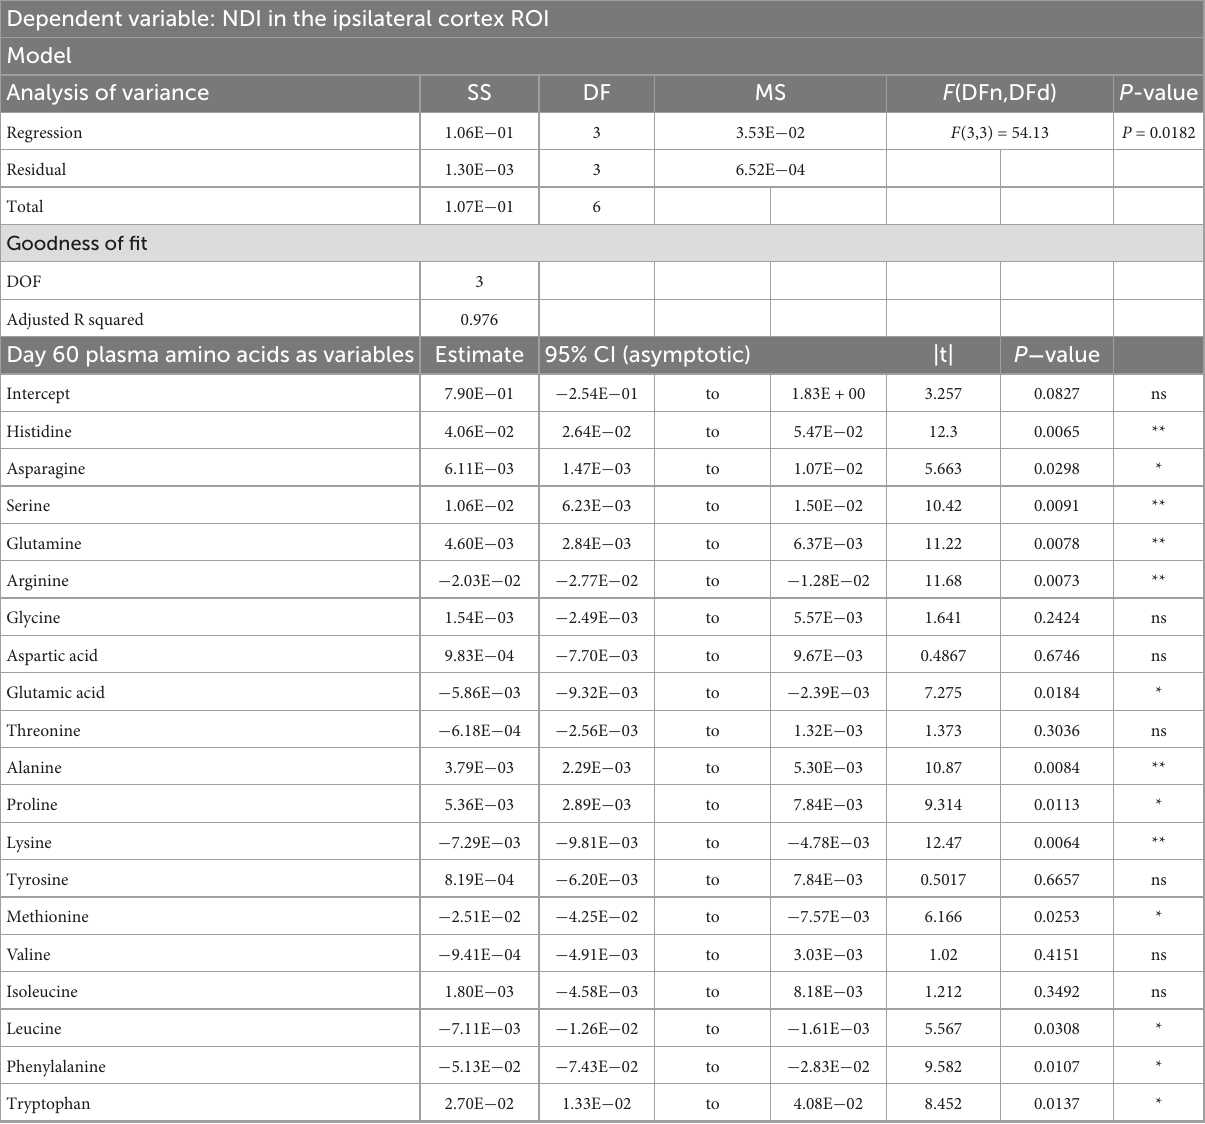
TABLE 5 Result of PCR predicting the neurite dispersion index (NDI) quantified from the ipsilateral cortex ROI from the plasma amino acid panel at day sixty post-injury. Dependent variable: NDI in the ipsilateral cortex ROI